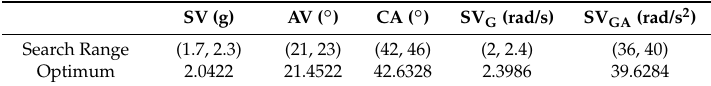
Table 3. Threshold ranges and values of Alg. 2 for the MobiAct